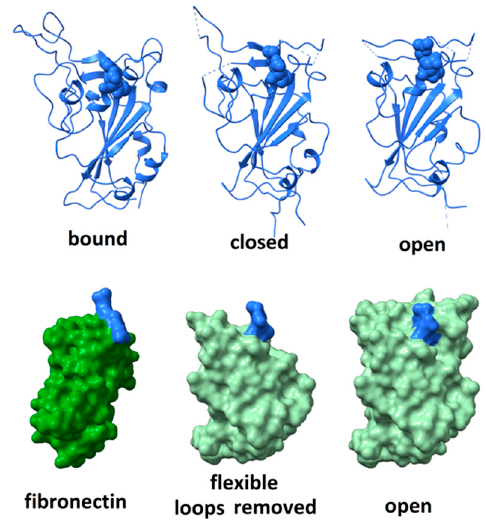
Figure 3. (top) Comparison of the structure of the receptor-binding domain when bound to ACE2 receptor (left—with ACE2 removed for clarity); (middle) unbound in the closed configuration; and (right) unbound in the open configuration. RGD motif rendered in space-fill. The distal surface loop undergoes dramatic rearrangements in different environments. (bottom) The receptor-binding domain of SARS CoV-2 spike protein in the “open” conformation (right and middle) compared to the structure of the integrin-binding domain 10 of fibronectin (left). Space-fill rendering to show the degree of exposure for the RGD domain when the flexible distal tip (residues 437 to 508) of the receptor-binding domain is removed (middle). The RGD motifs are indicated in blue.